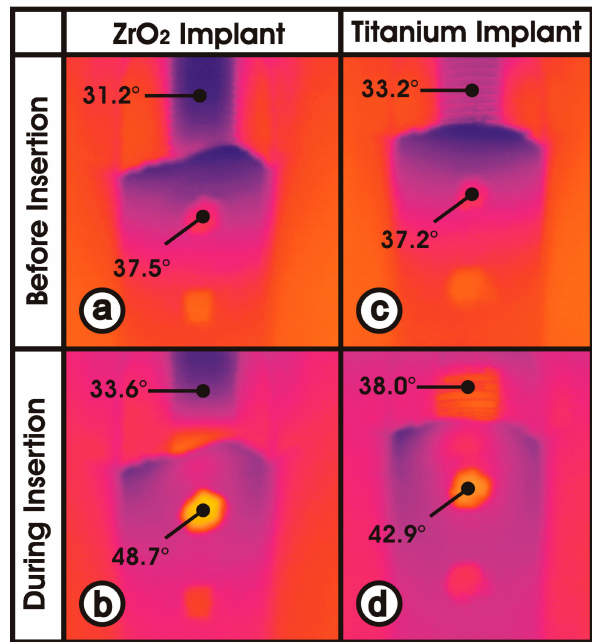
Figure 7. Material-dependent heat dissipation. ( a ) ceramic implant before insertion; ( b ) ceramic implant during insertion; ( c ) titanium implant before insertion; ( d ) titanium implant during